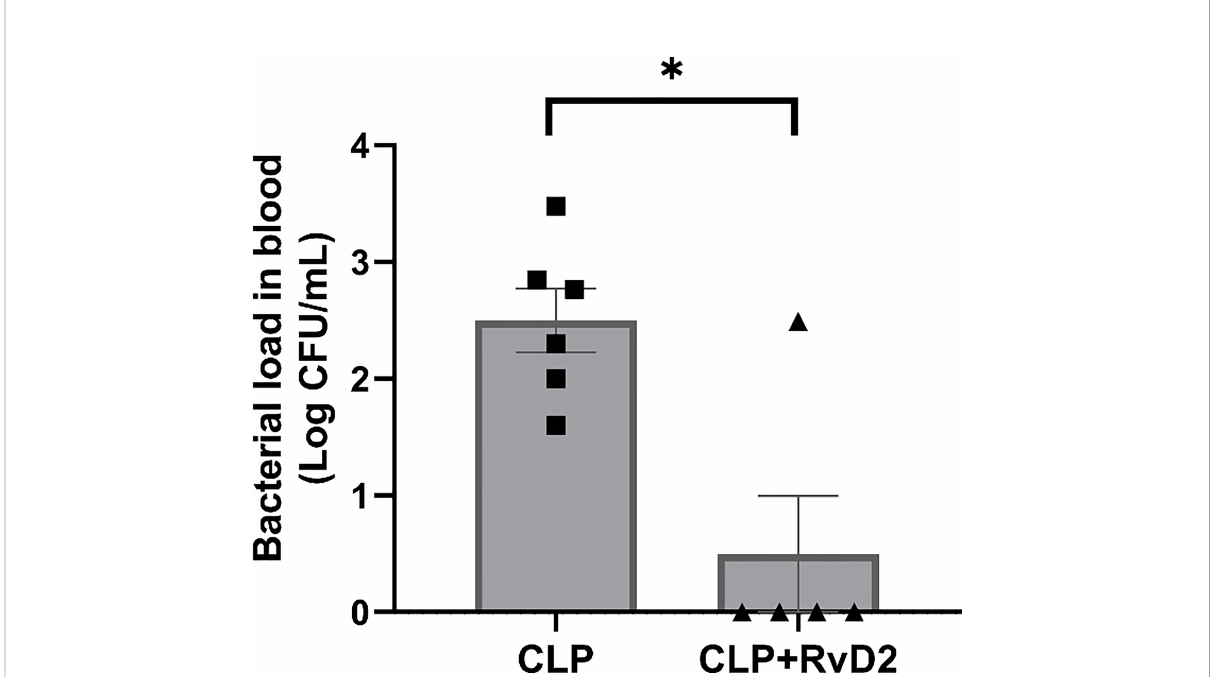
FIGURE 2 CLP mice were given vehicle saline or RvD2 48h after surgery. Mice were sacri fi ced 24h later and blood sample were taken. Samples were serially diluted, plated on TSA plates and colony forming units (CFUs) were counted 24 hours after plating. RvD2 reduced the blood bacteria load. * P < 0.05, for n = 5 - 6 mice in each